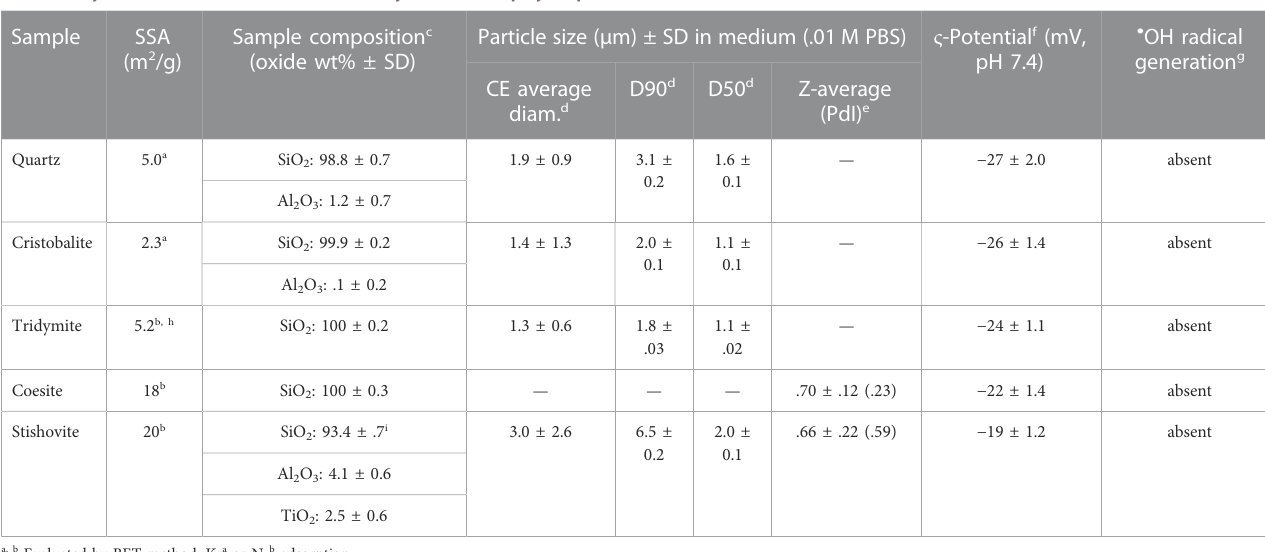
TABLE 1 Physico-chemical characteristics of the crystalline silica